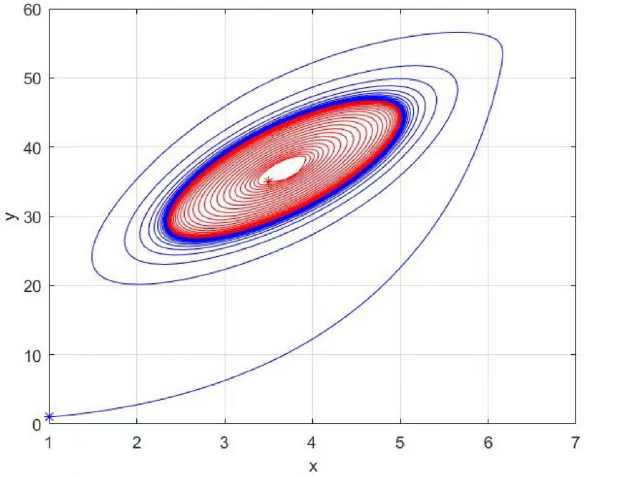
Figure 3. The two phase trajectories with delay in unstable